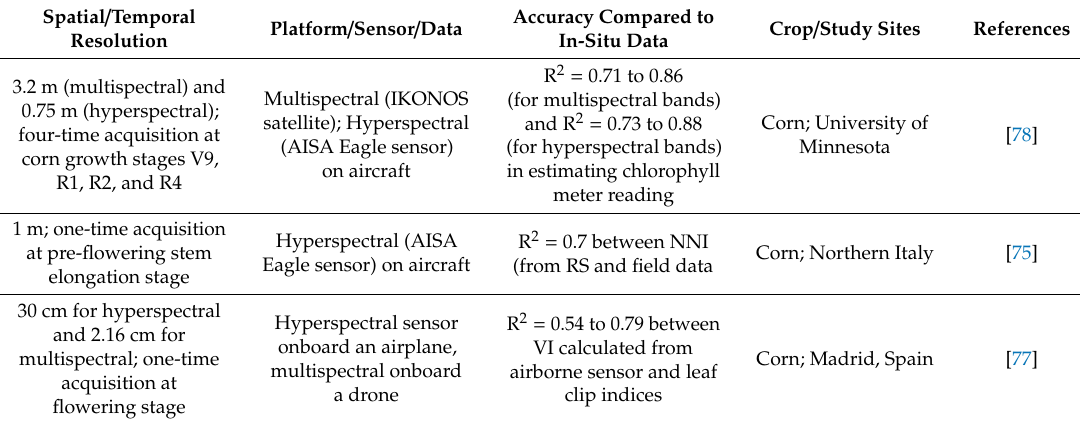
Table 6. Studies conducted for nitrogen stress monitoring using RS data from multiple